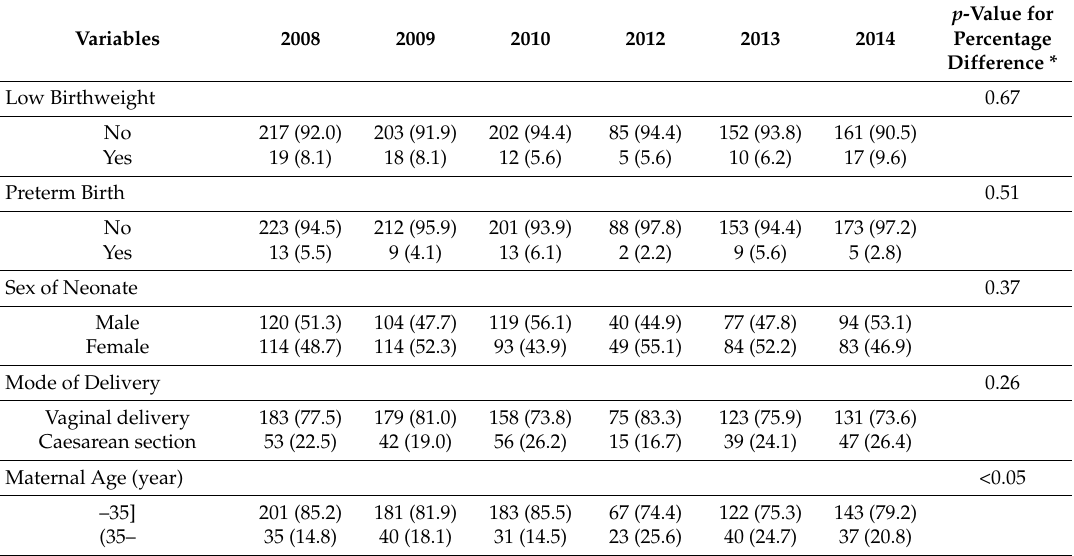
Table 1. Maternal and neonatal demographic characteristics by year ( n ,